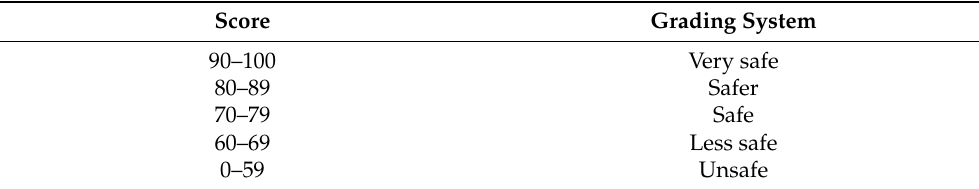
Table 5. Input indicator scoring